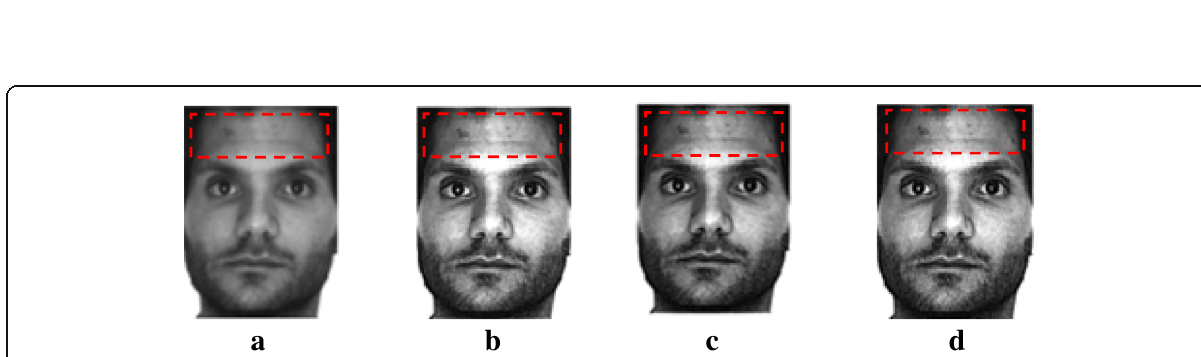
Fig. 7 Qualitative comparison of the different evaluation function with the CSO algorithm on Image 2. a Original. b Munteanu + CSO. c Ye +